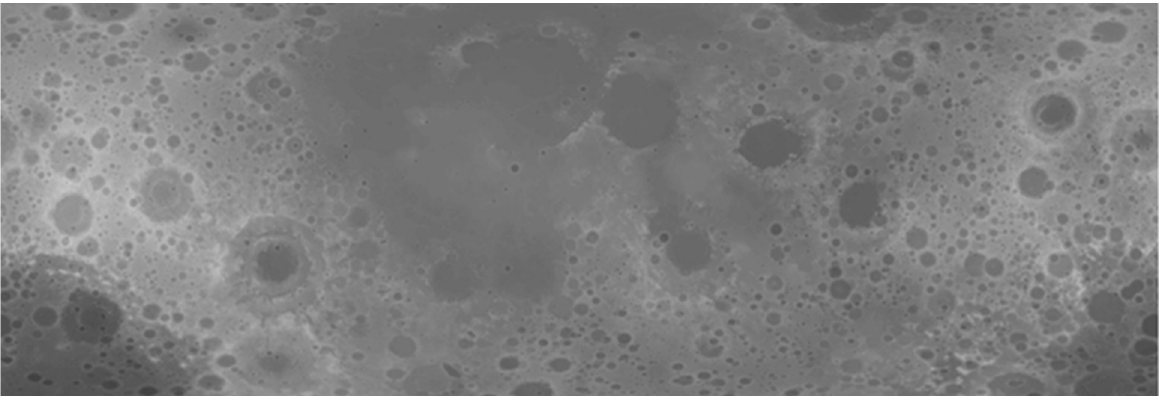
Figure 1. Digital elevation model in the longitude range [ − 60°, 60°] and latitude range [ − 180°, 180°] for the lunar image.